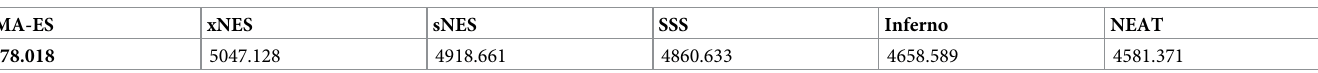
Table 3. Performance of the best controllers evolved with the 5 methods and of the best human-designed driver available in TORCS v1.3.7 called “Inferno” (i.e. the human programmed controller that achieves the best performance on the CG1-track circuit, see http://torcs.sourceforge.net/index.php?name=News&file= article&sid=100). All controllers, including Inferno, have been tested and evaluated in the same conditions. CMA-ES xNES sNES SSS Inferno NEAT 5078.018